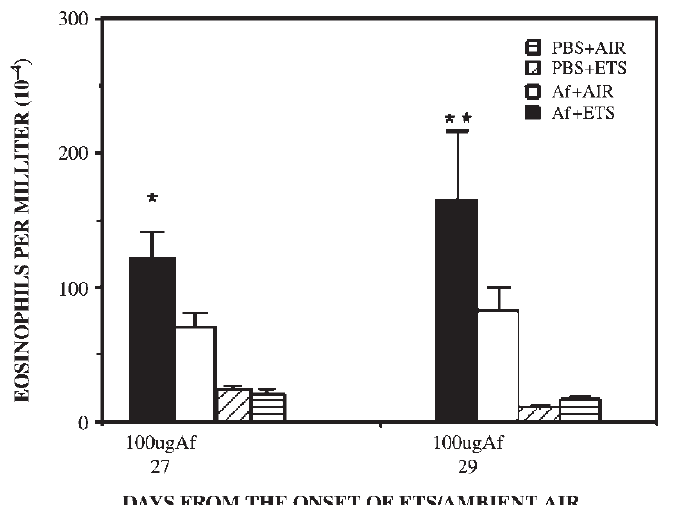
FIGURE 3 Eosinophil levels in the blood of BALB/c mice after exposure to ETS or ambient air. Experimental protocol was as described in Fig. 1. Blood samples were collected in heparinized tubes and diluted in Descombe’s fluid Colley, 1972 for eosinophil determination. BALB/c mice were sensitized i.n. with either 200 m g Af per challenge or 100 m g Af per challenge. * Indicates p , 0 : 05; versus all other groups ð n ¼ 10 Þ : † Indicates p ¼ 0 : 0177 versus Af þ ETS group ð n ¼ 23 Þ